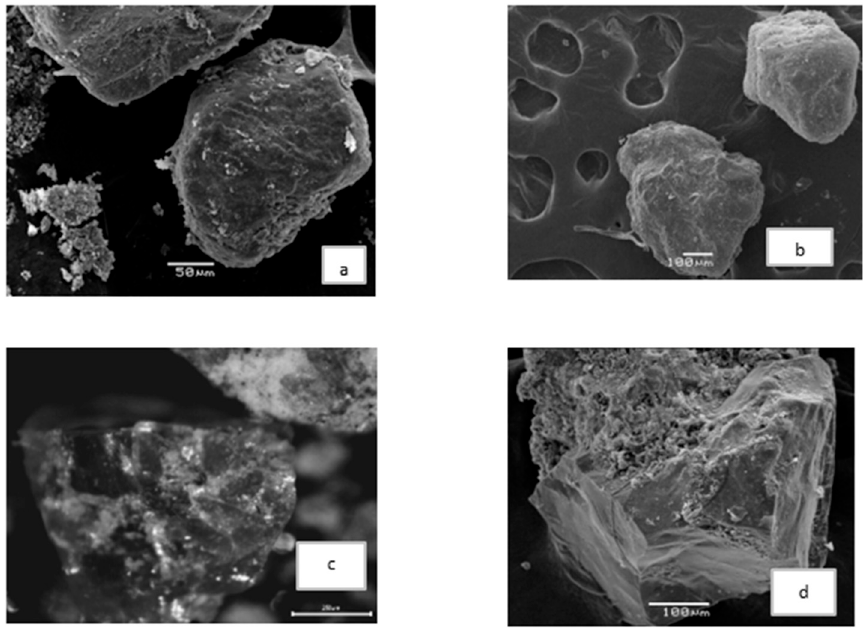
Figure 9. Surface morphology of quartz grains: ( a )—microdeposits; ( b , d )—stepped cleavage; ( c )—glossy surface. Binocular ( c ). SAM JSM-6380 LA. ( a , b , d ). The scale is 50 μ m ( a ), 100 μ m ( b , d ), and 20 μ m ( c ).